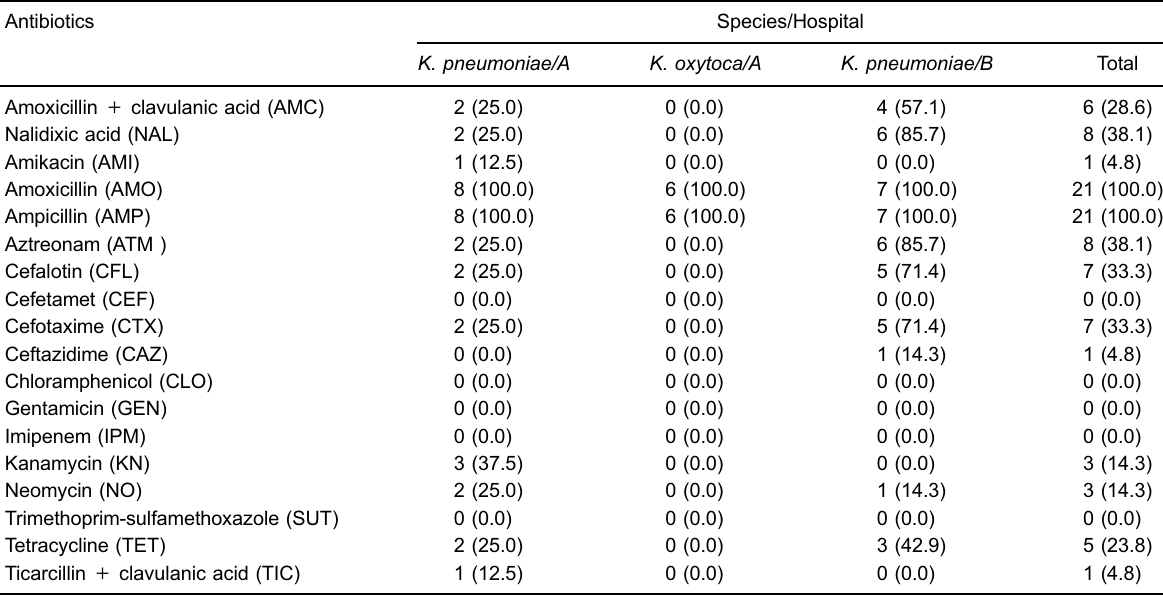
Data are reported as number with percentage in parentheses. A: Hospital A; B: Hospital B. See Material and Methods for details.